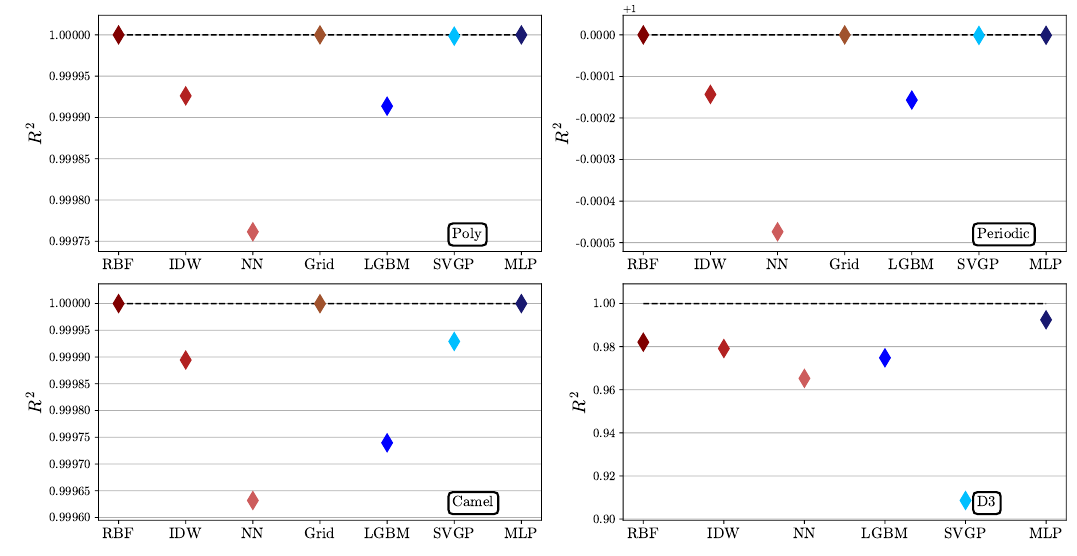
Figure 7: R 2 values in 3 dimensions for the three toy functions and